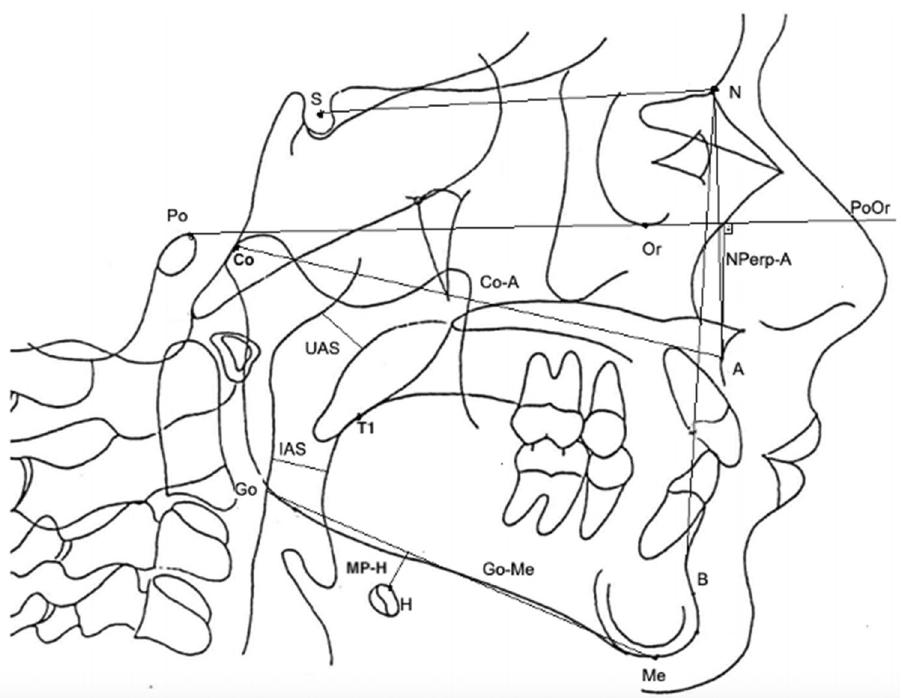
Figure 1. S (Sella); N (Nasion); Or (Orbital); Po (Porion); A (Point A); B (Point B); Me (Mentus); Go (Gonius); H (Hyoid); Co (Condylum); T1 (Tongue